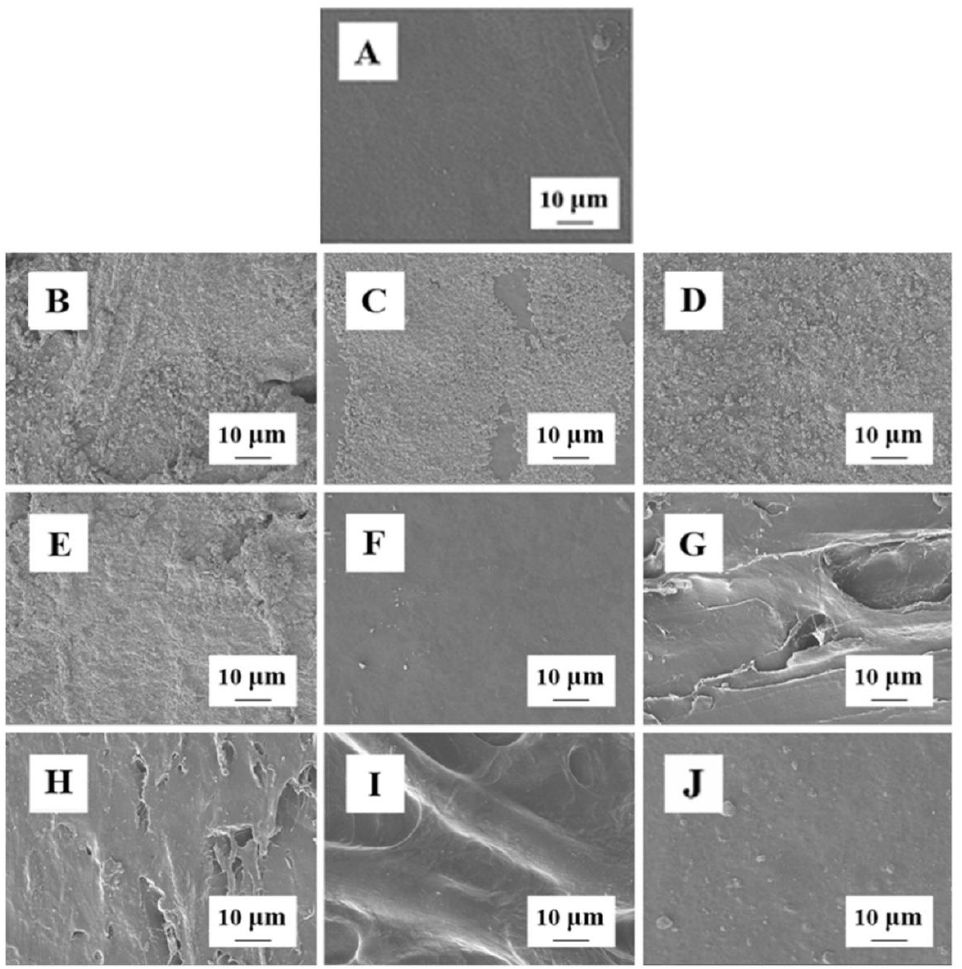
Figure 8. The microstructure composite films (( A ) control; ( B ) Rose essential oil; ( C ) Fennel essential oil; ( D ) Nano ‐ SiO 2 ; ( E ) Nano ‐ TiO 2 ; ( F ) Nano ‐ Ag; ( G ) CMC ‐ C/nano ‐ Ag; ( H ) CMC ‐ H/nano ‐ Ag; ( I ) CMC ‐ B/nano ‐ Ag; and ( J ) Nano ‐ Ag/NBC, respectively).